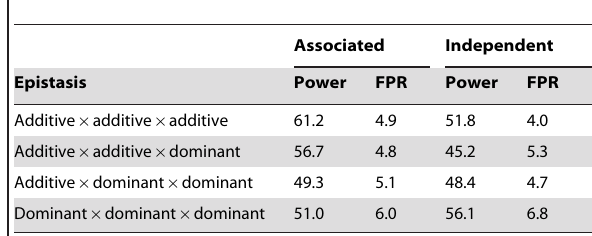
Table 11. Power and false positive rates (FPR) for the detection of three-locus epistasis among associated and independent SNPs for 200 cases and 200 controls.